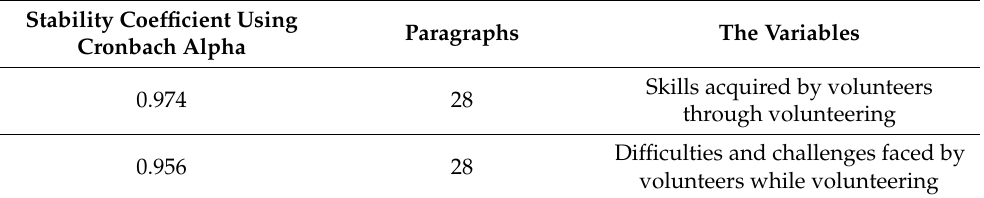
Table 2. Cronbach Alpha test for stability coefficients for study tool paragraphs. Stability Coefficient